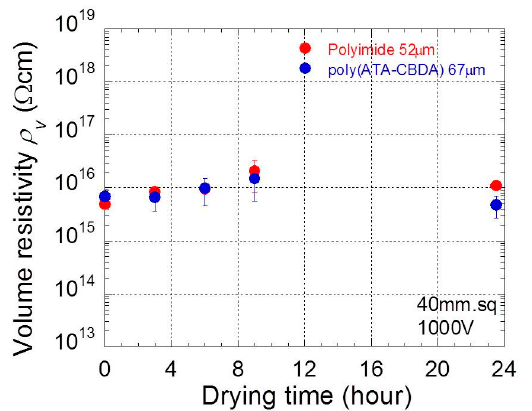
Figure 8. Relationship between electric resistivity at 1000 V and drying time for polyimide and biopolyimide films.